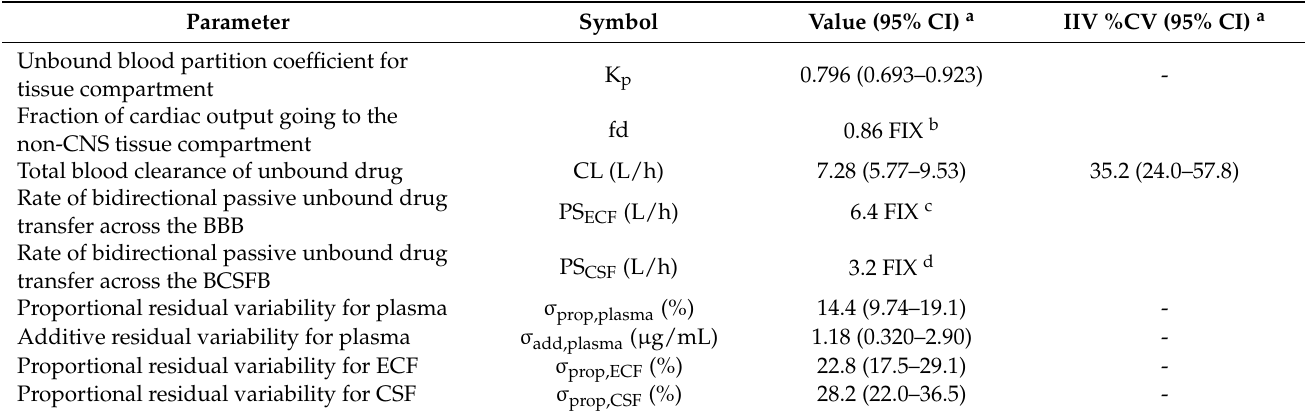
Figure 1. Visual predictive checks of the final PBPK model for unbound metronidazole concentrations in plasma, brain dialysates after correction by in vivo probe recovery (Brain Dialysate ) and collection bag of the EVD (CSF EVD ). Circles represent observed data; the solid lines correspond to the median and the grey-shaded area depict the 90% prediction interval delimited by the 5th and 95th percentiles (dashed lines) for 1000 simulated profiles. Table 1. Parameter estimates for metronidazole in plasma, ECF and CSF.